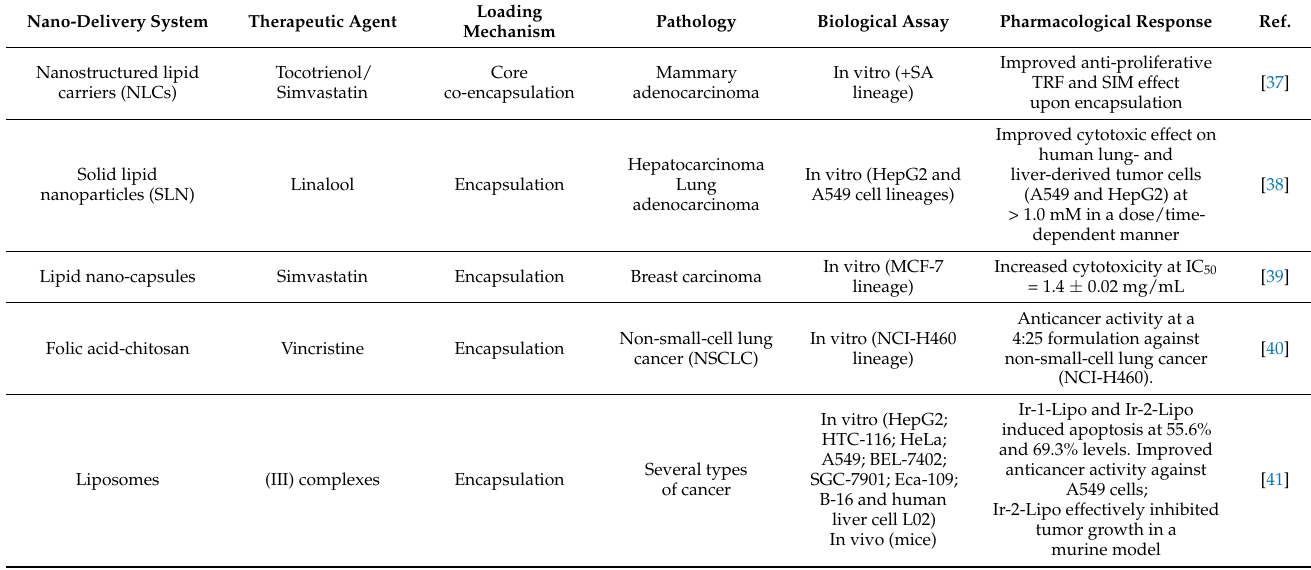
Table 1. Pre-clinical studies on nano-delivery systems demonstrated in cell cultures and animal models for the loading of therapeutics aiming at the treatment of several health